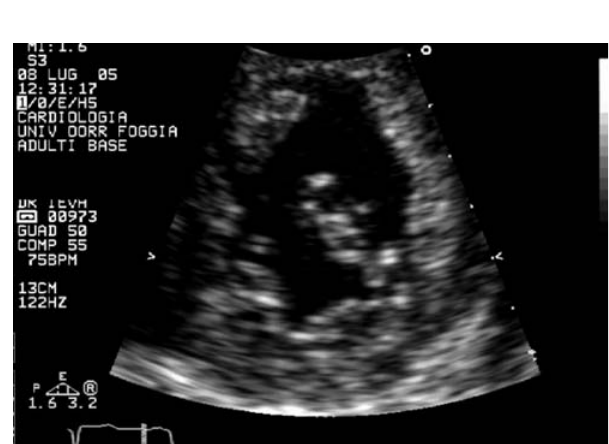
Figure 1 - Detail of the three-leaflet tricuspidvalve